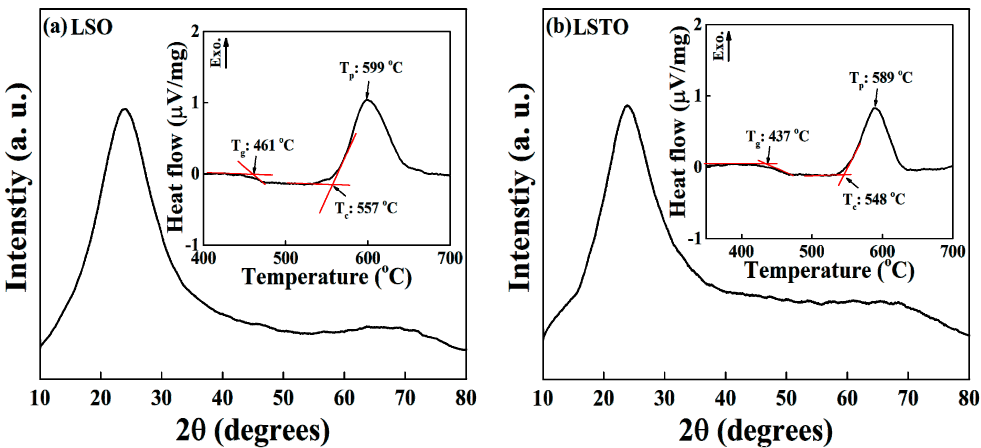
Figure 1. XRD patterns of the ( a ) Li 2 O-2SiO 2 (LSO) and ( b ) 0.9 (Li 2 O-2SiO 2 )-0.1 TeO 2 (LSTO) glasses at room temperature. The XRD patterns in Figure 1a,b were averaged for five times scan data with each scan 0.05-degree step for three seconds, in the scattering angle from 10 to 80 degrees. The broad XRD pattern is the typical glass characteristic scattered from the short ranging disordered network structure. Inset: DTA curves of ( a ) LSO and ( b ) LSTO glasses. The heating rate is 10 ◦ C / min. We denote T g for the glass transition temperature, T c for the crystallization temperature and T p for the exothermic peak temperature.